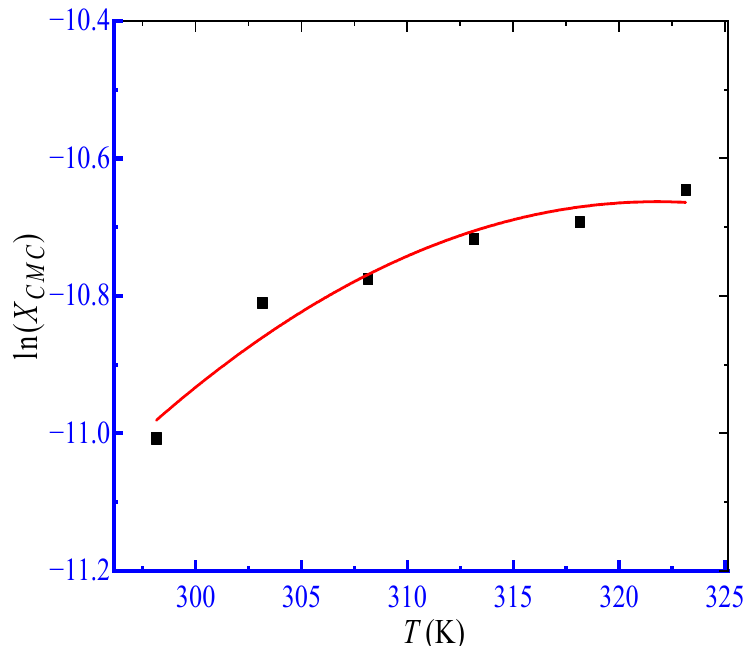
Figure 2. A second-order polynomial fitting of lnX CMC vs. T plot for the assembly of CPC + 0.1% ( w / v ) PVP systems in water. Table 6. Enthalpy–entropy compensation parameters for CPC + 0.1% ( w / v ) PVP systems in H 2 O and Table 5. The values of A , B , and C for the aggregation of CPC + 0.1% ( w / v ) PVP mixed aq. salts solution.